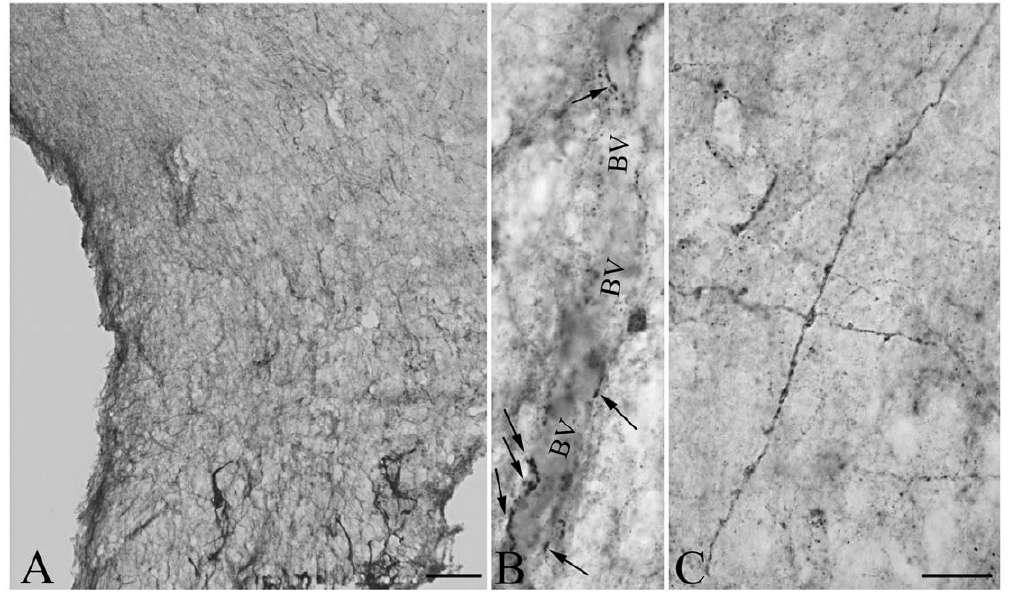
Figure 11. MCT8-immunoreactivity in the infundibular stalk of the human hypothalamus. A dense network of MCT8-immunoractive axons is present in the infundibular stalk ( A ) . A high magnification image illustrates MCT8-immunoractive axon varicosities in the proximity of a putative portal blood vessel (BV) in the neurovascular zone of the infundibular stalk ( B, arrows) . Long, MCT8-immunoractive axons with large varicosities are frequently encountered ( C ). Scale bar: 100 m m in A, 20 m m in C (also corresponds to B).